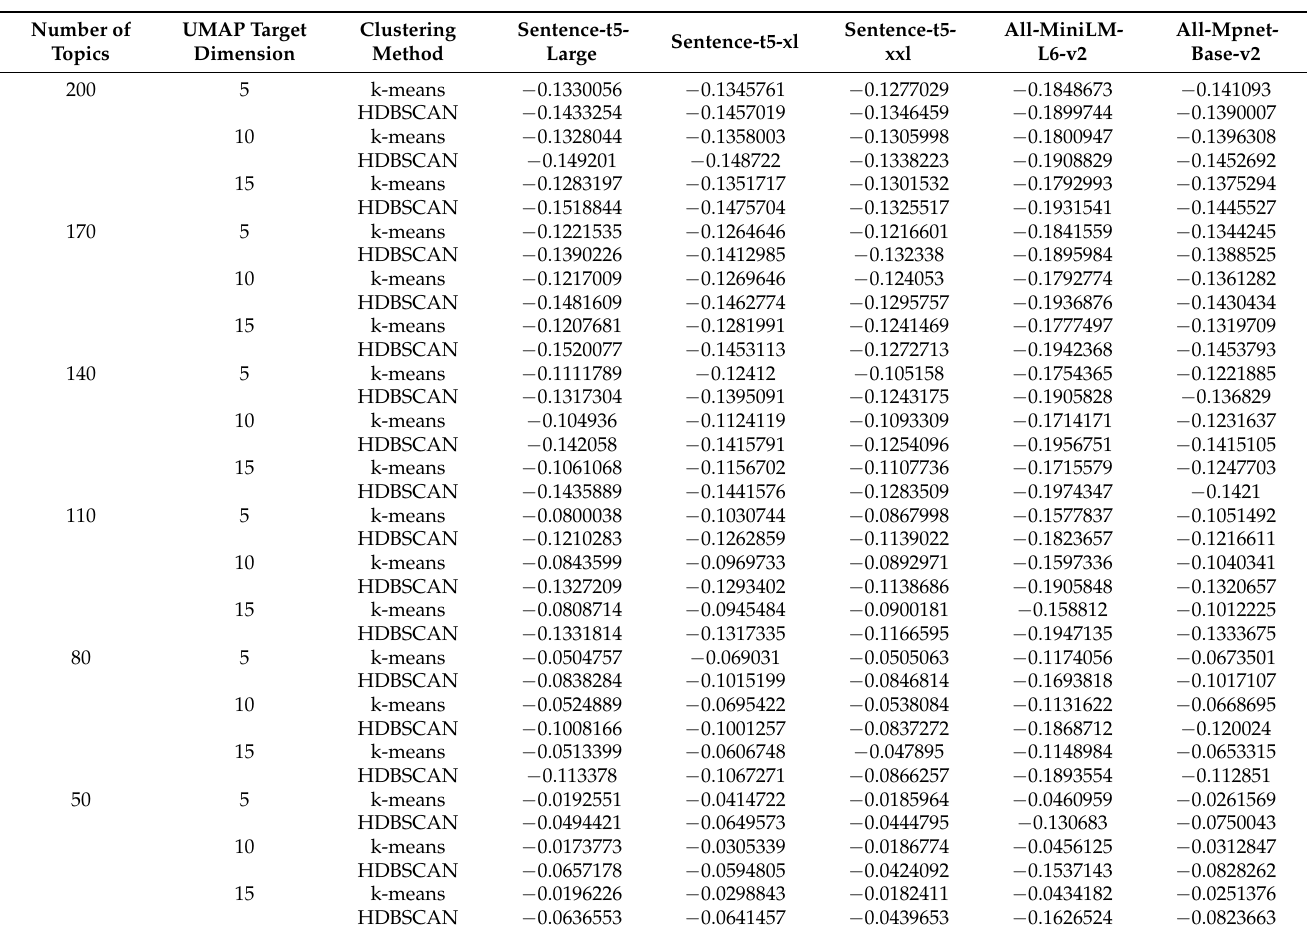
Table A1. Experimental